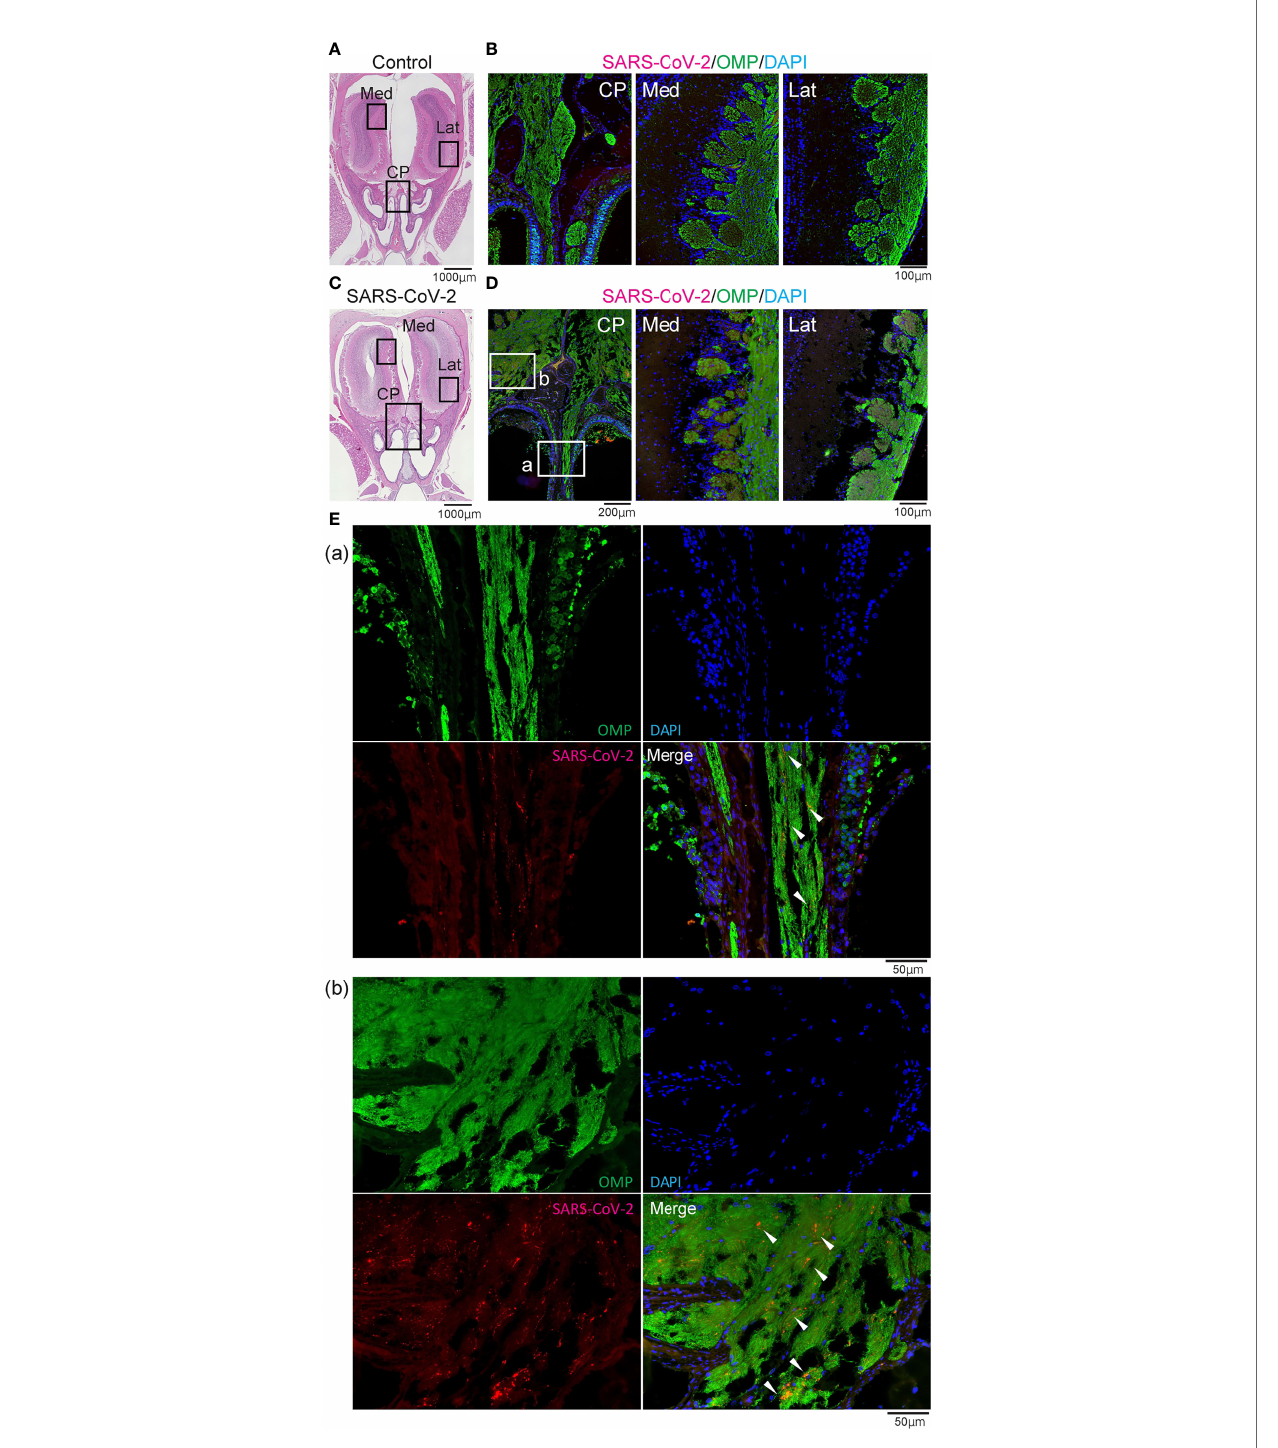
FIGURE 4 | Representative images of SARS-CoV-2 and OMP staining in the olfactory nerve bundles and olfactory bulb. Representative coronal section images of the olfactory bulb area. (A, B) Images of control hamsters (A: hematoxylin and eosin stain, B: immunohistological staining of severe acute respiratory syndrome coronavirus 2 (SARS-CoV-2), olfactory marker protein (OMP), and DAPI). The boxes in (A) indicate the areas shown enlarged in B; the cribriform plate area (CP), medial area (Med), and lateral area (Lat). (C – E) Images of SARS-CoV-2 hamsters ( C : hematoxylin and eosin stain, D, E : immunohistological staining of SARS-CoV-2, OMP, and DAPI). The boxes in (C) indicate the areas shown enlarged in (D) , and the boxes in (D) are shown enlarged in (E) . SARS-CoV-2 is present in the olfactory nerve of the nasal mucosa and the olfactory nerve fi ber layer around the olfactory